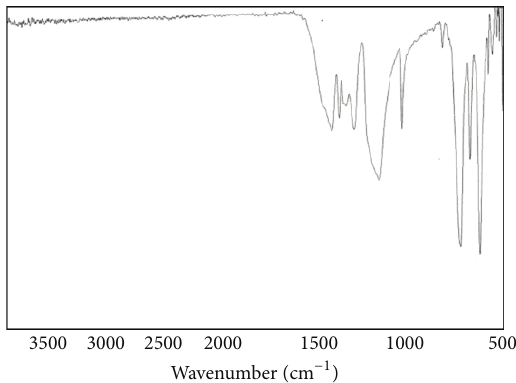
Figure 2: FTIR spectra of Ca 3 (BO 3 ) 2 synthesized by solution combustion